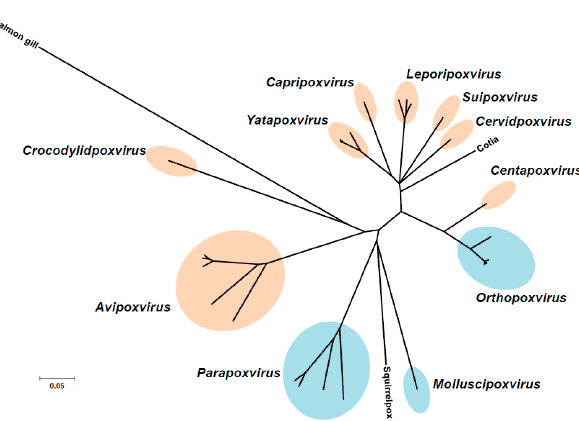
Figure 1. Genetic diversity of poxviruses. Genus in which French National Reference Center-Expert Laboratory for Orthopoxvirus (NRC-EL-OPX) isolates had been identified is highlighted in blue.